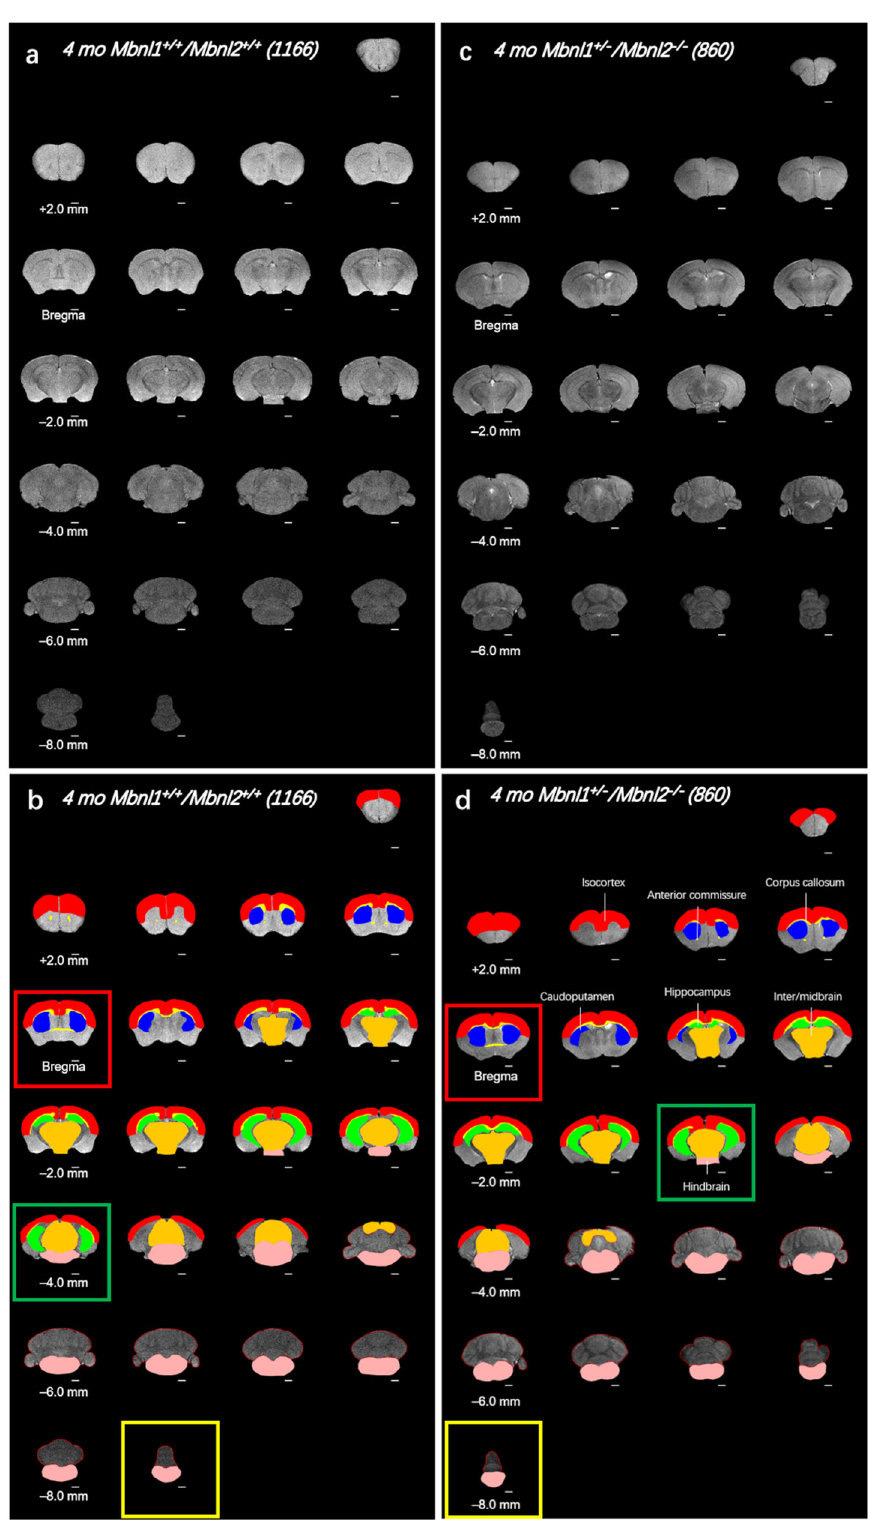
with age matched Mbnl1 + / + /Mbnl2 + / + mice (Fig. 3a, b; Table 1). Mbnl1 + / − /Mbnl2 − / − mice exhibited larger reductions in the anterior commissure volume (~49% decrease) at four months ( p = 0.0001) (Fig. 3c, d; Table 1). Gray matter volumes were measured in the cerebrum, brainstem, and cerebellum. In the cerebrum, the isocortex, hippocampus, and caudoputamen were measured. Mbnl1 + / − /Mbnl2 − / −